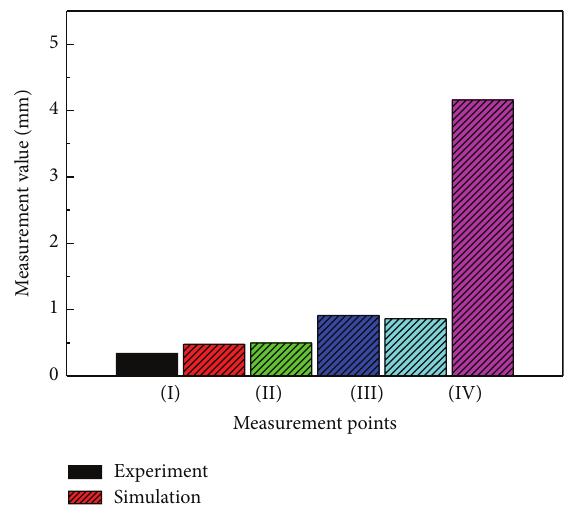
Figure 6: Comparison of experimental and FEM.